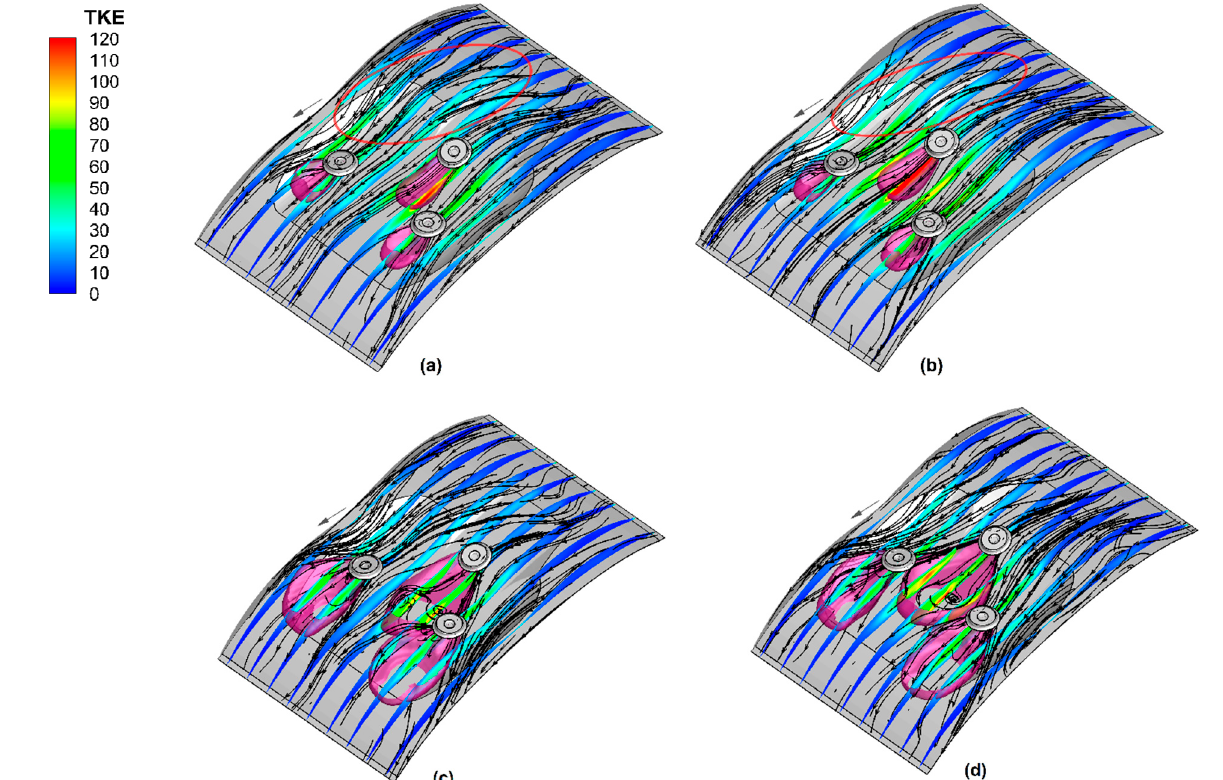
Figure 14. Distribution of TKE (m 2 /s 2 ) and representation of temperature iso-surface of 1500 K at 10 ◦ EA before TDC (10 ◦ EA after ST) for ( a ) L-slot (L-T-plug) and ( b ) C-slot (C-T-plug) and at TDC (20 ◦ EA after ST) for ( c ) L-slot (L-T-plug) and ( d ) C-slot (C-T-plug).